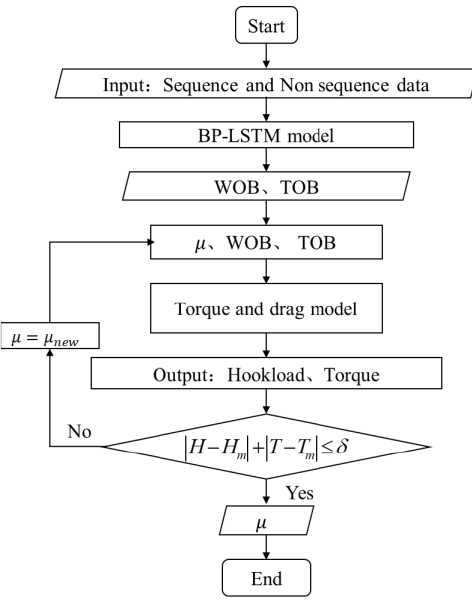
Figure 4. Flow chart of real time inversion for friction coefficient.